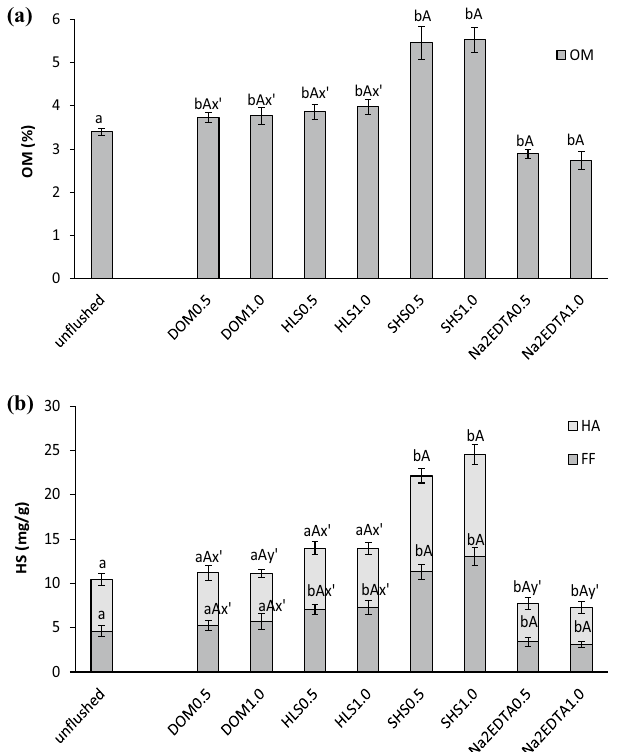
Figure 3. Changes in the content of organic matter (OM) ( a ), humic substances (HS) and their fractions, i.e. humic acids (HA) and fulvic fractions (FF) ( b ) in soil before and after flushing with DOM, HLS, SHS and Na 2 EDTA. Small letters (ab) indicate statistically significant differences in the content of OM, HA and FF between the unflushed and flushed soils, capital letters (AB) indicate significant differences between the flow rates with one WA. The symbols x’ or y’ indicate no statistically significant differences between some